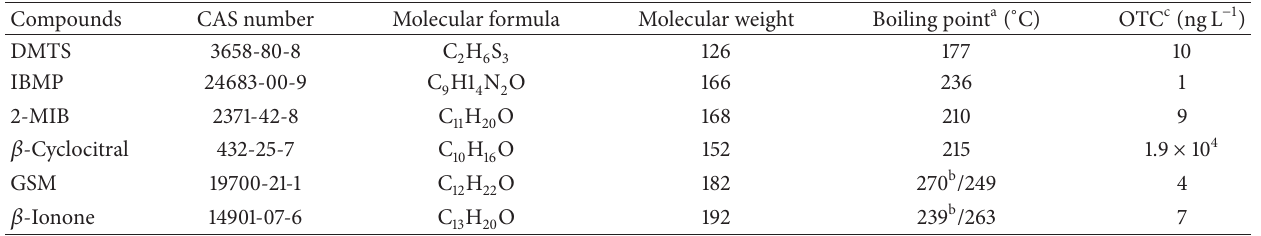
Table 1: The CAS number, molecular weight, boiling point, and odor threshold of the six